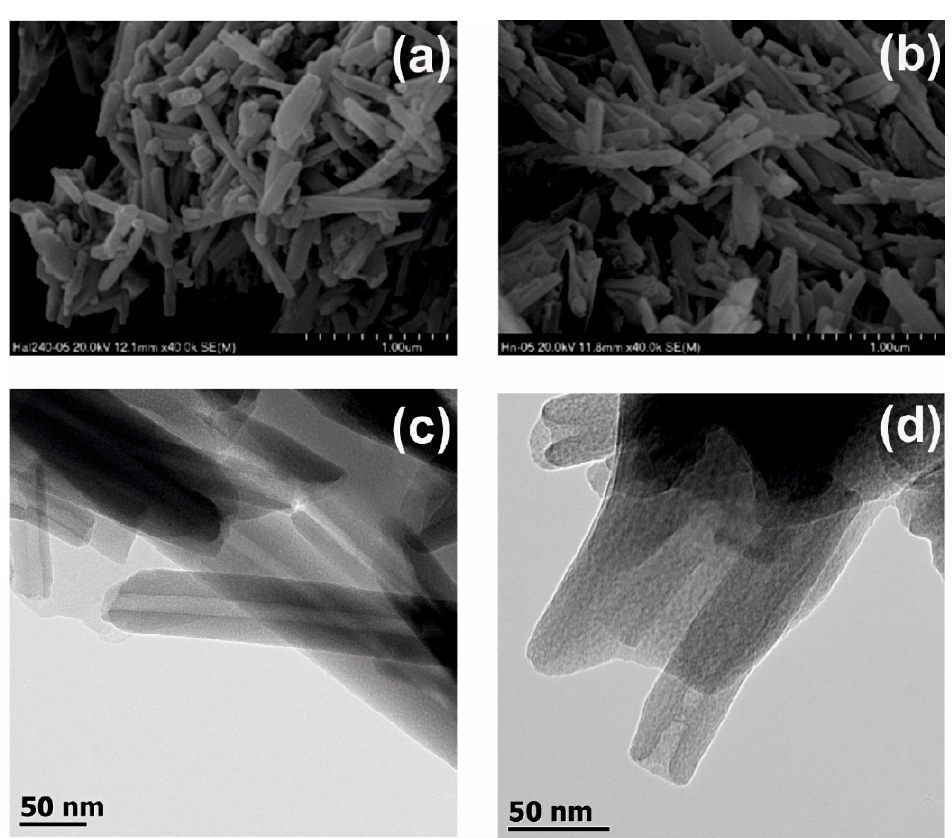
Figure 1. ( a ) SEM image obtained for HNT-CP, ( b ) SEM image obtained for EHNT-CP, ( c ) TEM image obtained for HNT-CP and ( d ) TEM image obtained for EHNT-CP.